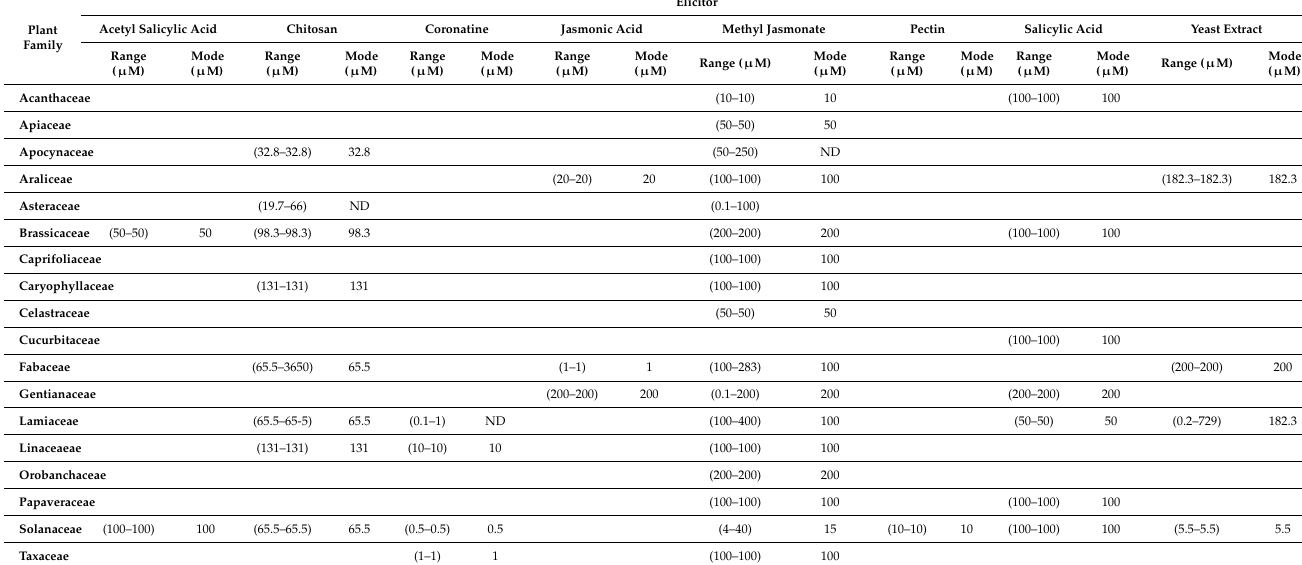
Table 5. Concentration range and mode value ( μ M) of each elicitor by plant family, from 2010 to 11 January 2022.